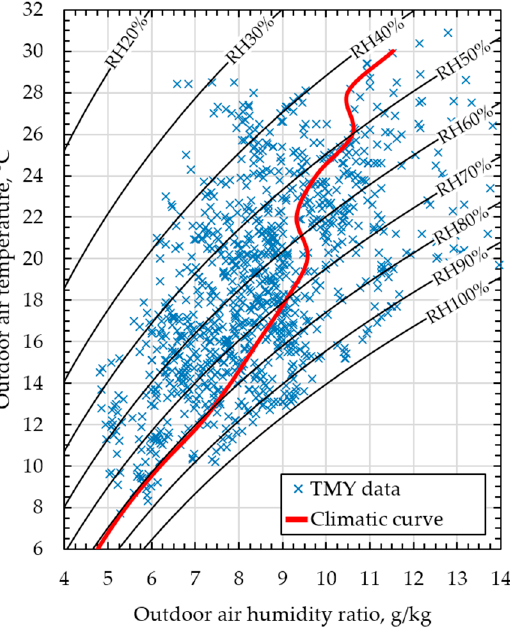
Figure 3. Outdoor air conditions for Wroclaw during operating hours of the analyzed room.